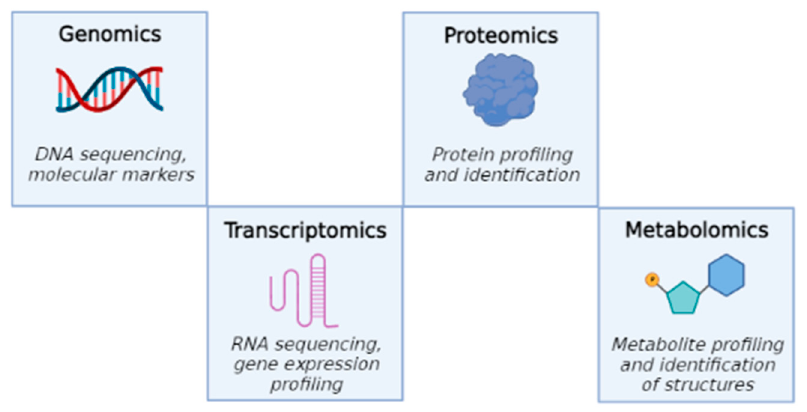
Figure 1. Four major “omics” fields, starting from genomics to metabolomics.